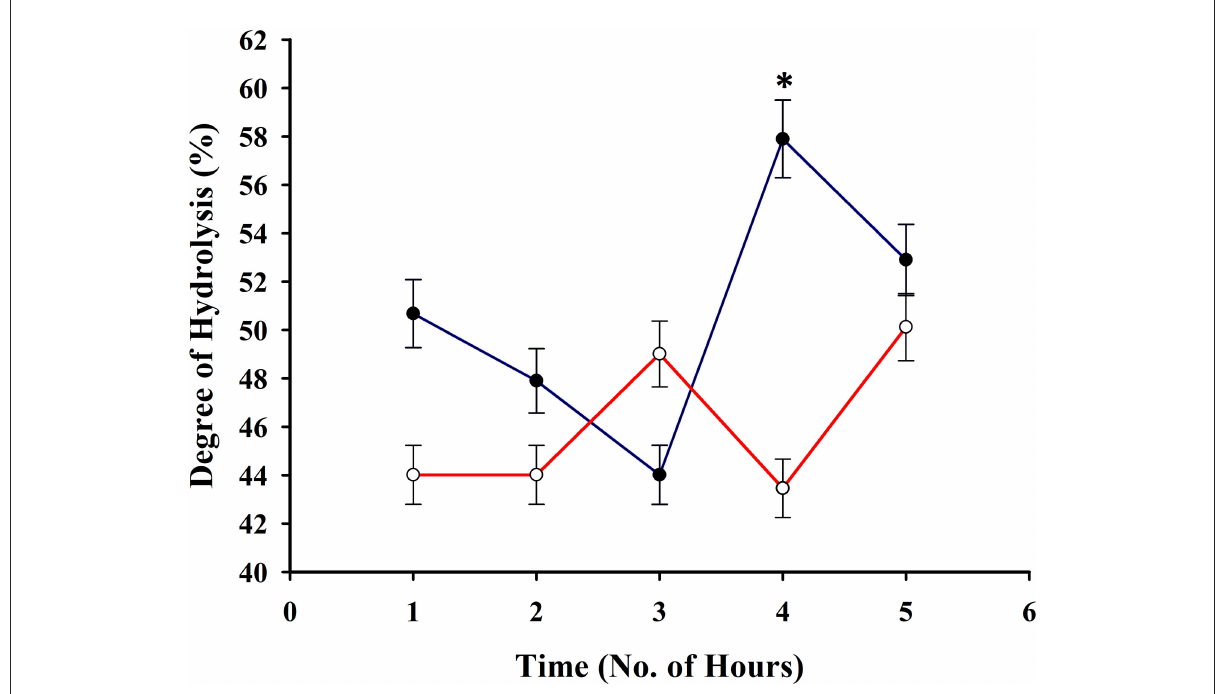
FIGURE2 Degree of hydrolysis of squid by-products at 0.25% (red line) and 1% (blue line) enzyme to substrate ratio. The asterisk indicates a significant difference between treatments.